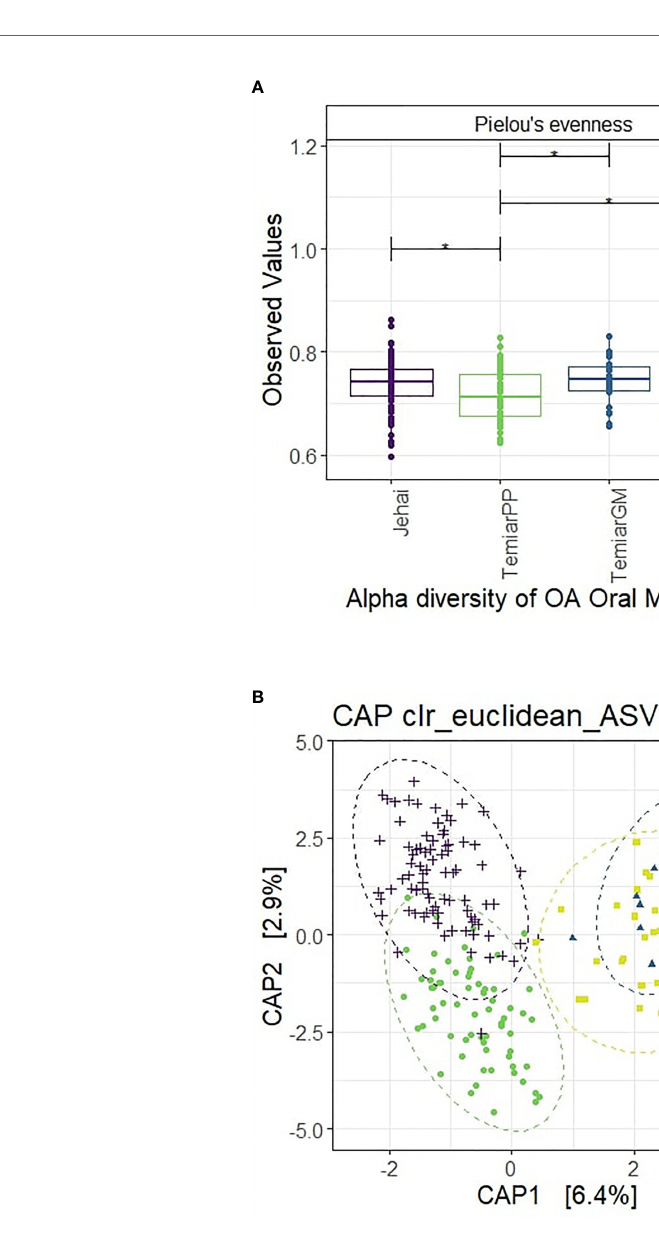
FIGURE 1 | (A) Alpha diversity of OA oral microbiota unexpectedly low and homogenous (* p-value < 0.05). (B) Supervised CAP ordination plot shows distinct clusters with rural Jehai and Temiar PP microbiota grouping away from urban-like Temuan and Temiar